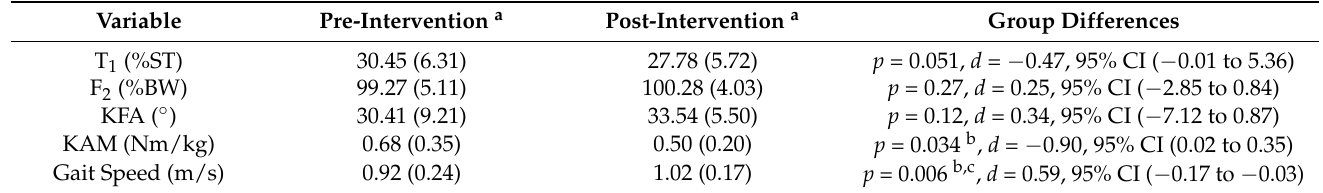
Table 2. Results of pre- and post-treatment repeated measures t-tests for biomechanical data.